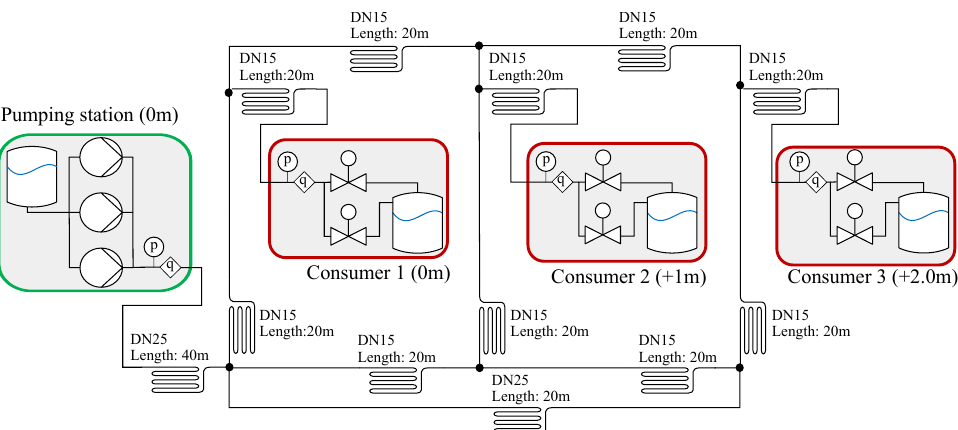
Figure 6. Diagram of the hydraulic network used as reference for the design of the modules with a single pumping station and three consumer units representing aggregated end-users in a city district.